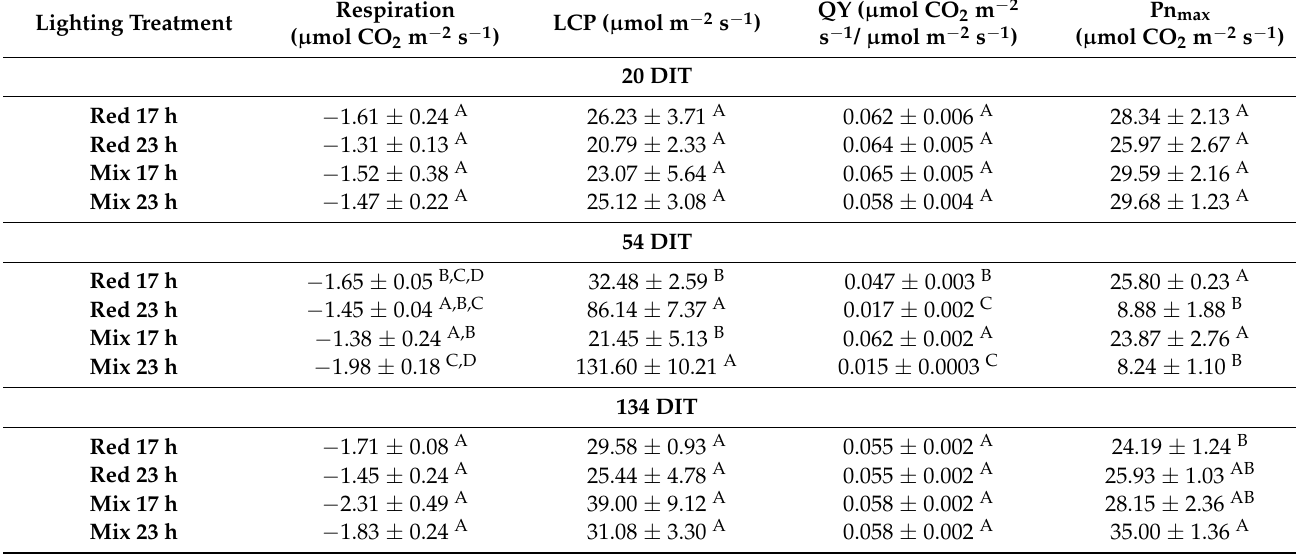
Figure 6. Photosynthetic light response curves from TE leaves grown under either red 17 h, red 23 h, mix 17 h, or mix 23 h lighting treatments at 20 DIT (5 December 2018, panel A ), 54 DIT (8 January 2019, panel B ), and 134 DIT (29 March 2019, panel C ) as determined using a Li-COR 6400 with a red/blue standard Li-COR light source. Measurements were performed at a CO 2 concentration of 800 µ L L − 1 , leaf temperature of 24 ◦ C, and a relative humidity of 55–65%. Regression lines were fit to y = y o + a(1 − e ( − b ∗ x) ) for each lighting treatment. Panels ( D – F ) are magnifications of 0–100 µ mol m − 2 s − 1 PAR regions fit to the regression line y = mx + b. Table 2. Summary of the major physiological traits as determined by leaf light response curves (Figure 6) from tomatoes grown under red 17 h, red 23 h, mix 17 h, and mix 23 h at 20 (5 December 2018), 54 (8 January 2019), and 134 DIT (29 March 2019). Respiration values were the averages of NCER when the light level was 0 µ mol m − 2 s − 1 . The light compensation point (LCP) and quantum yield (QY) were calculated from a regression line (y = mx + b) fitted to the values between the PAR values of 0–100 µ mol m − 2 s − 1 . The photosynthetic maximum (Pn max ) was calculated from y = y o + a(1 − e ( − b ∗ x) ). Values ± the standard error of the mean are representative of n = 3. Within each parameter and time of measurement, letter groups (A, B, C, D) represent a statistical difference as determined by a two-way ANOVA with a Tukey–Kramer adjustment ( p < 0.05).